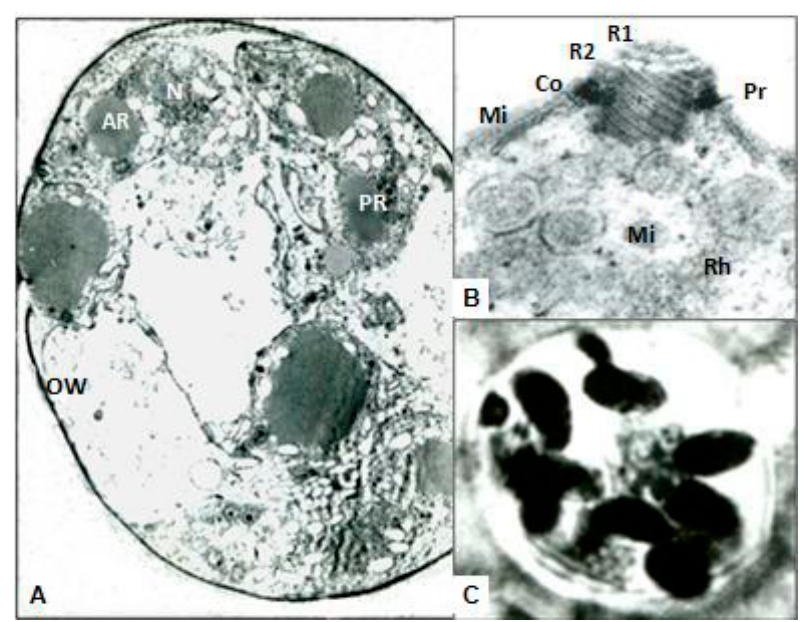
Figure 2. ( A – C ) Mature aberrant organism. ( A ) Transmission electron micrograph (TEM)